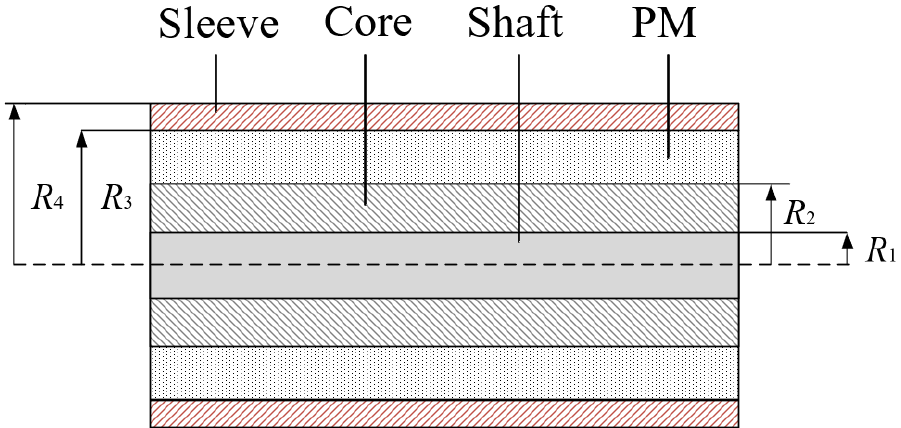
Figure 18. Stress analysis model of the sleeve–PM–core–shaft structure rotor.